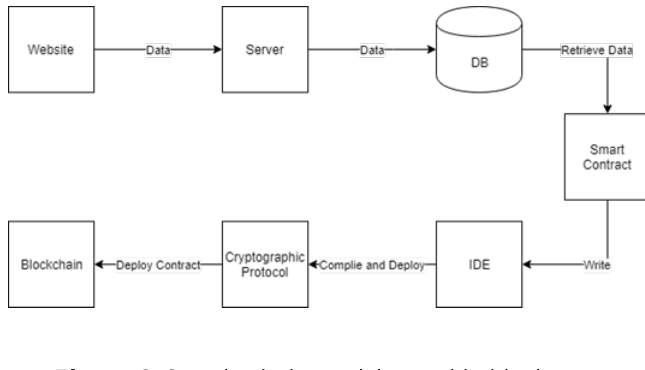
Figure 6. Supply chain participant side block diagram for proposed system